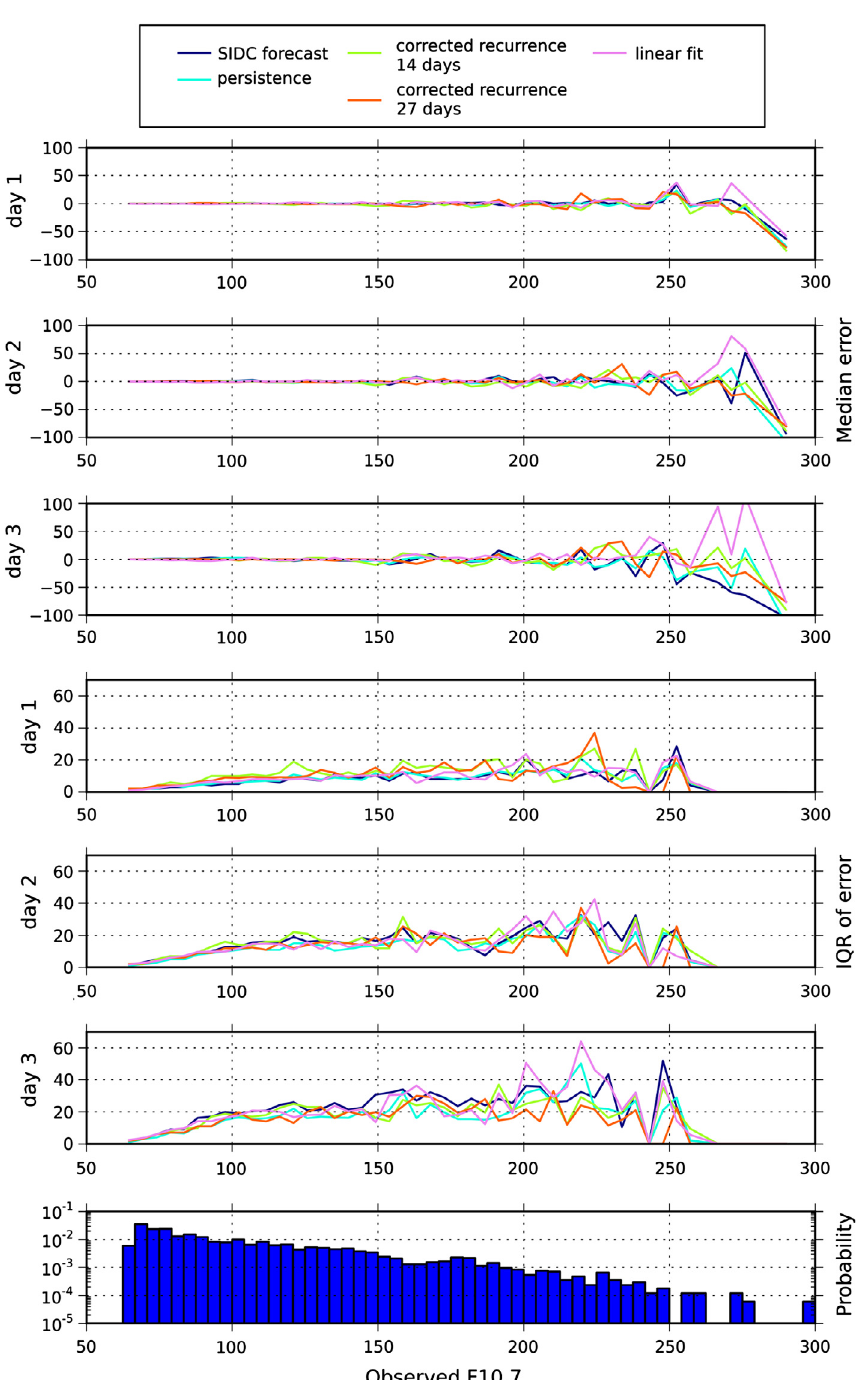
Fig. 3. Errors conditional on the observed flux values. The plot includes results for the SIDC forecast and the numerical models persistence, corrected recurrence of 14 and 27 days and linear fit. The three top panels show the median error (Sect. 3.1.1) conditional on the observed flux for days 1–3 respectively. The three following panels display the interquartile range (Sect. 3.1.1, IQR) of the error conditional on the observed flux for days 1–3 respectively. The bottom panel shows the histogram of the observed